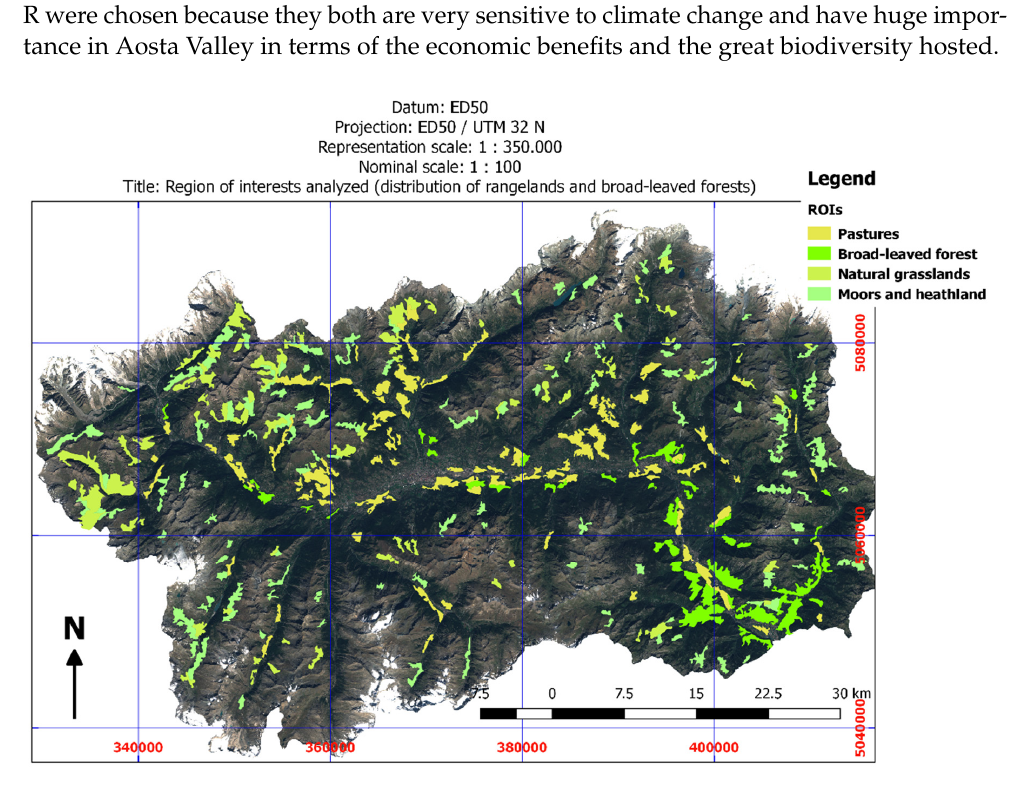
Figure 2. Map showing the spatial distribution of land cover classes (from the Coordination of Information on the Environment (CORINE) land cover map) that were considered for the study: pastures (code 231), broad-leaved forests (code 311), natural grasslands (code 321) and moors/heathland (code 322).